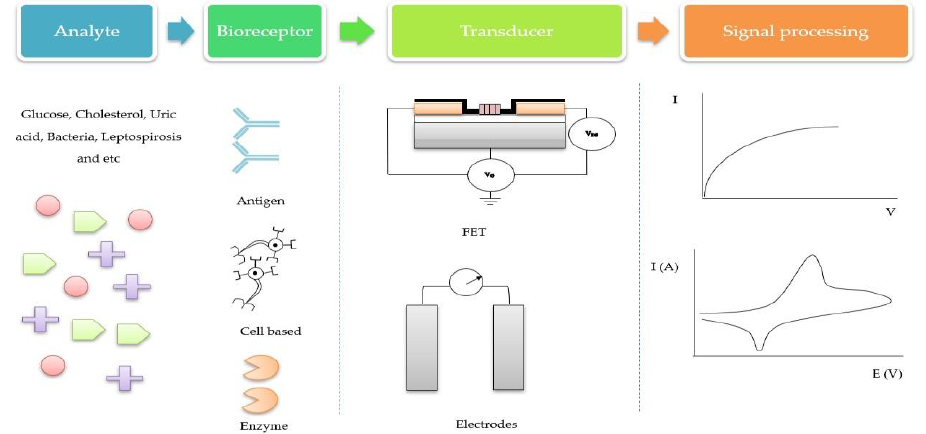
Figure 2. Illustration of an electrochemical biosensor system.